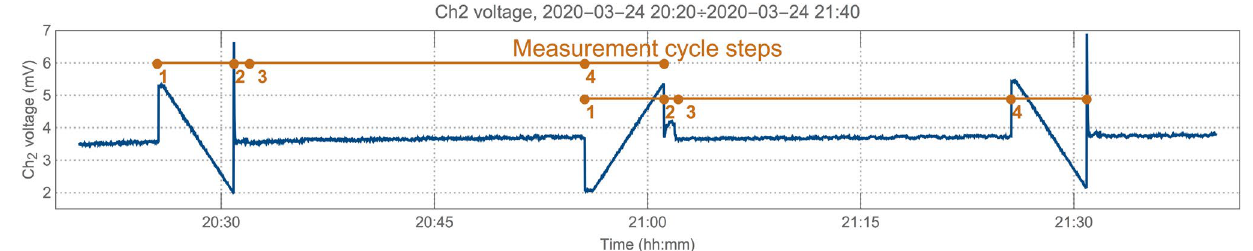
Figure 3. Sample readings of the Ch 2 detector during two successive 30min cycles along with both cycles steps numbers are presented. Reversing laser current step is visible at the 1st step of the second